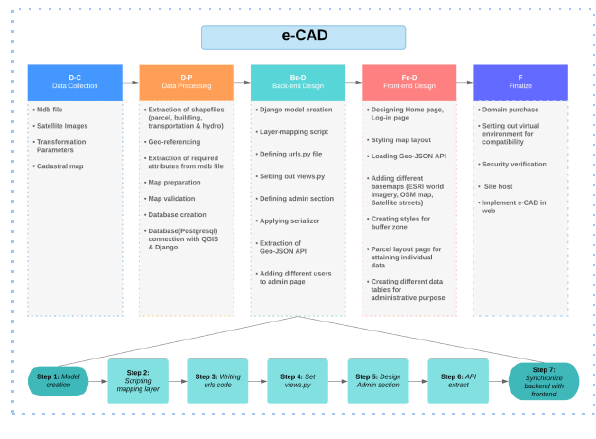
Figure 1. Workflow